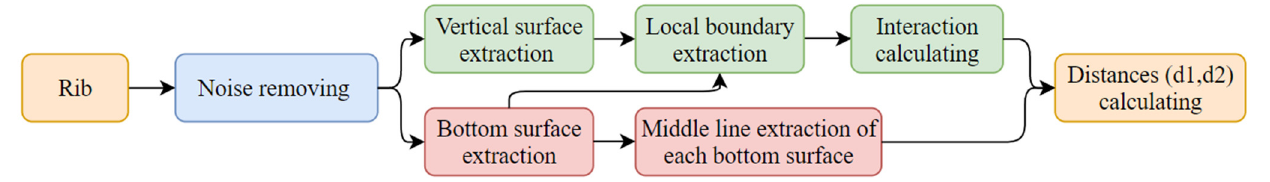
Figure 8. Flowchart of the T-rib location assessment.